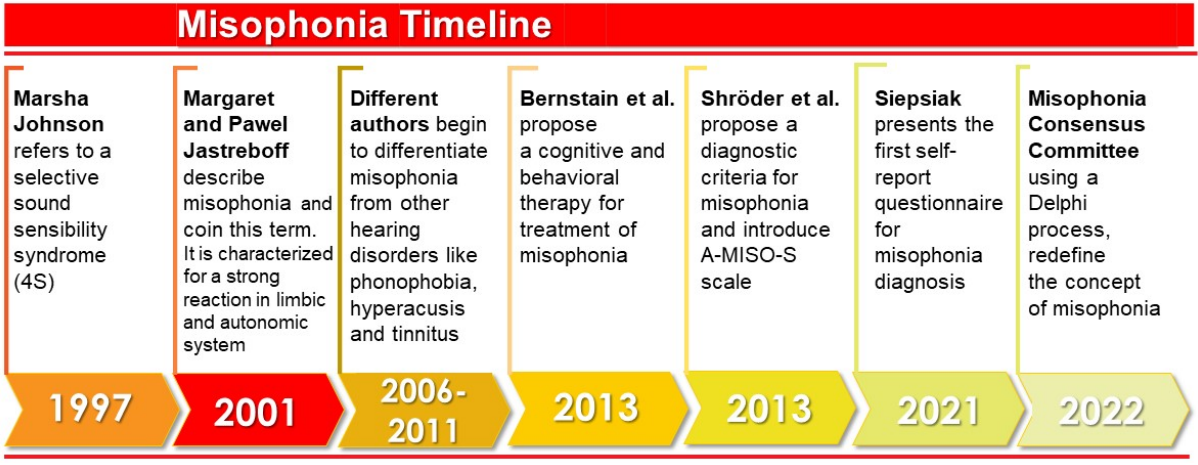
Figure 3. Timeline of outstanding studies related to misophonia (Own elaboration).